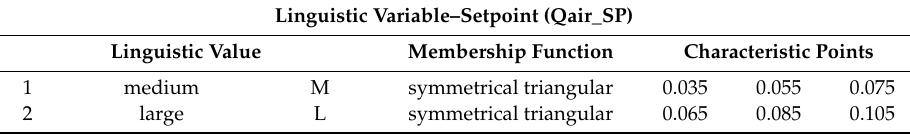
Table 6. The second version of the controller–Qair_SP.